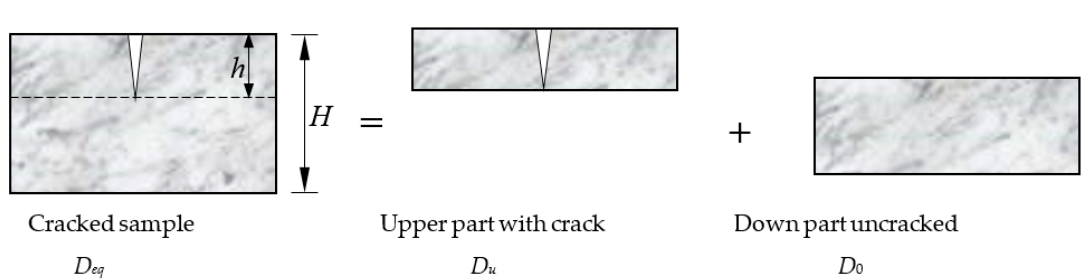
Figure 1. Partition hypothesis of resistance for cracked specimen.